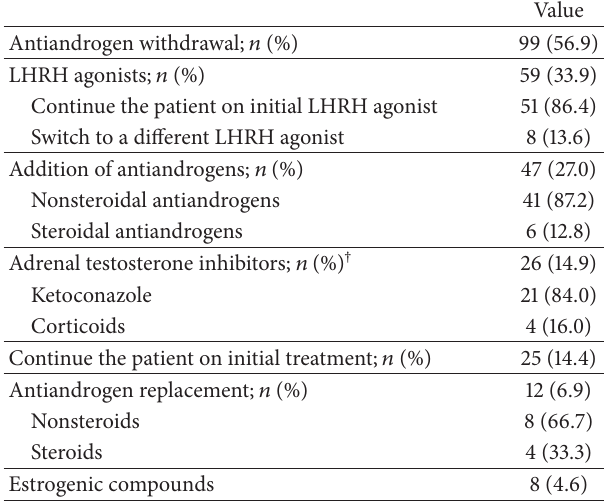
Table 3: Secondary hormonal treatment approaches ( 𝑛 = 174